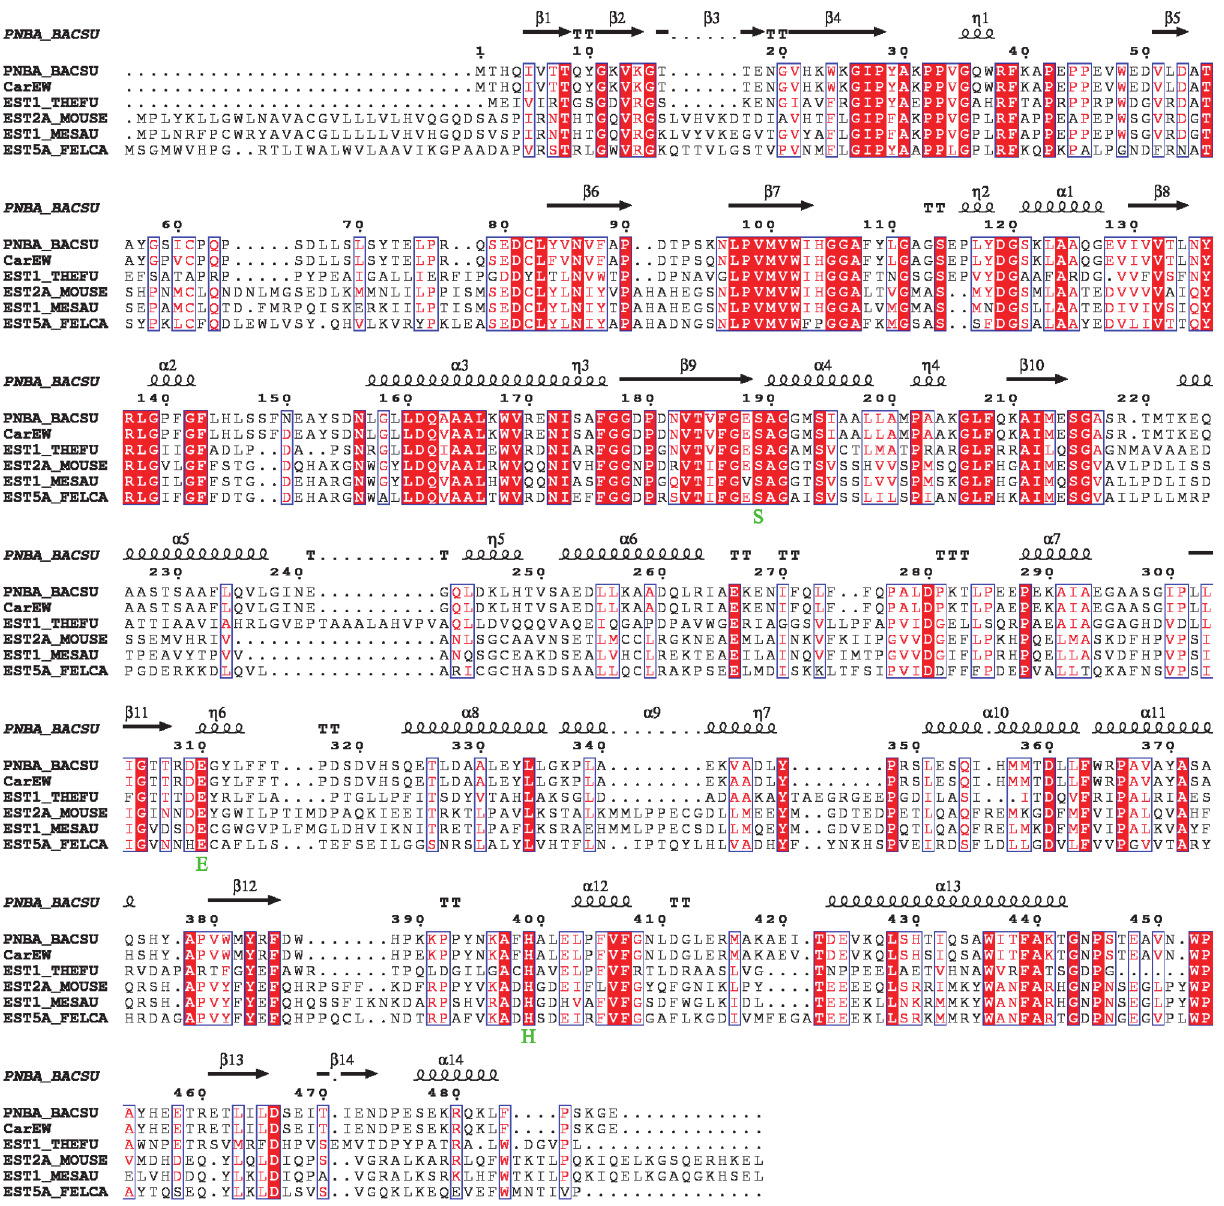
Fig 1. Protein sequences alignment between CarEW and homologs from the carboxylesterase family. ESPript outputs obtained with the sequences from the SWISSPROPT databank and alignment with CLUSTAL W. Sequences are grouped according to similarity. PNBA_BACSU, PNB (Para-nitrobenzyl esterase) carboxylesterase from B . subtilis subsp. Subtilis str. 168; CarEW, carboxylesterase from B . subtilis K91; EST1_THEFU, carboxylesterase from Thermobifida fusca ; EST2A_MOUSE, pyrethroid hydrolase Ces2e from Mus musculus ; EST1_MESAU, liver carboxylesterase from Mesocricetus auratus ; and EST5A_FELCA, carboxylesterase 5A from Felis catus . Conserved motifs are highlighted. Residues strictly conserved among groups are shown in white font with red background. The possible catalytic triad (serine (S), glutamic acid (E), histidine (H)) is shown at the bottom of the alignment in green font.